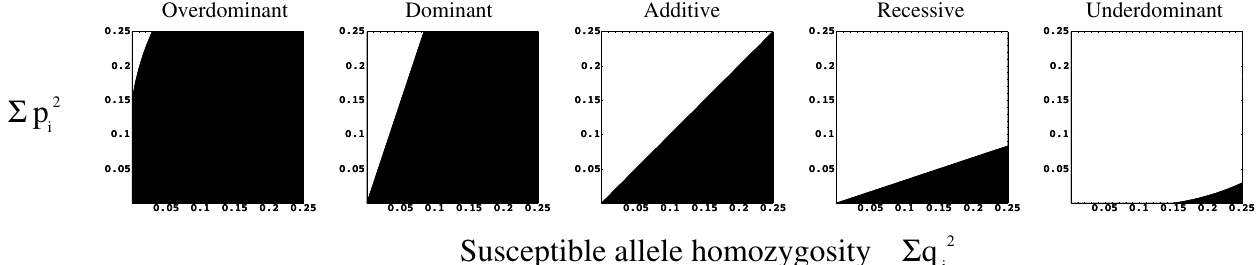
Figure 1 Population heterozygote advantage as a function of allele-specific effects and allele frequencies. Parameter regions in which heterozygotes will on average have a higher probability of a favorable disease outcome than homozygotes (regions of population heterozygote advantage) are shown in black. Population heterozygote advantage occurs when diversity of resistant alleles is sufficiently high and diversity of susceptible alleles is sufficiently low i.e., toward the bottom right of the parameter space in each panel of the figure. Different panels indicate various assumptions about the genotype-specific relative risks a - d (defined in Table 1). Parameters: Overdominant ( a = 1.1, b = 1.6, c = 2, d = 1.5); dominant ( a = 1, b = c = d ); additive ( a = 1, b = (1 + c )/2, c = d ); recessive ( a = b = 1, c = d ); underdominant ( a = 0.5, b = 0.9, c = 1.4, d = 1.5). These curves are drawn for p = 0.5. Dominant, additive and recessive curves are valid for all possible values of the free parameters, while under- dominant and overdominant curves are examples whose positions depend on the particular values of the parameters a , b , c and d